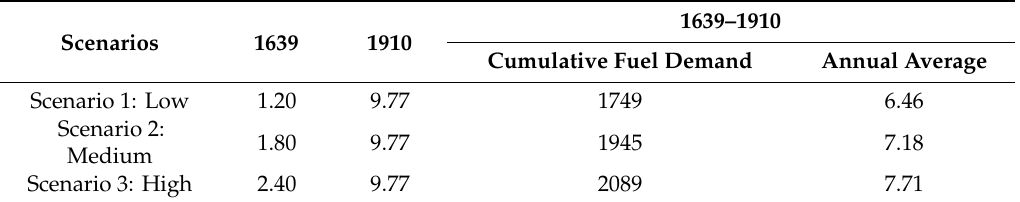
Table 3. Forest litter demand by scenario (unit: million